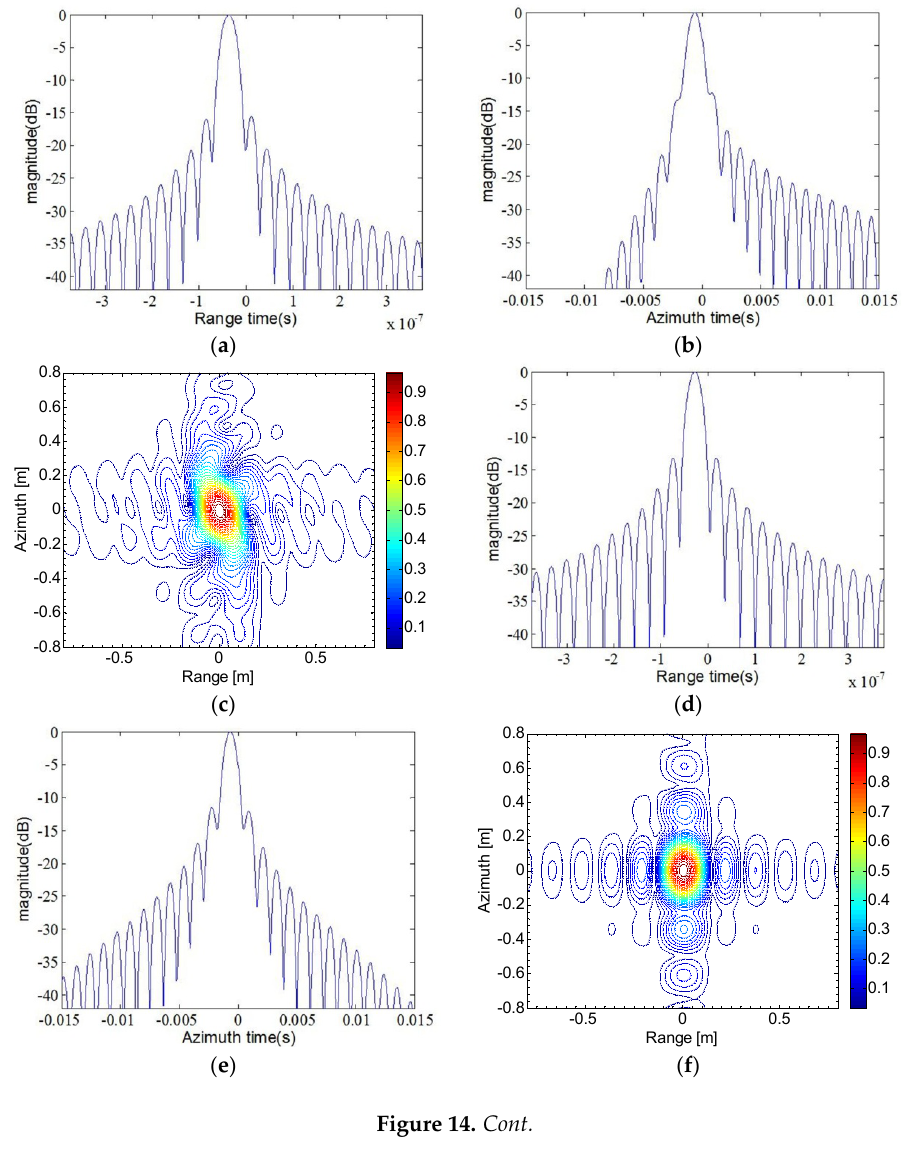
Figure 14. Cont. Figure 14.